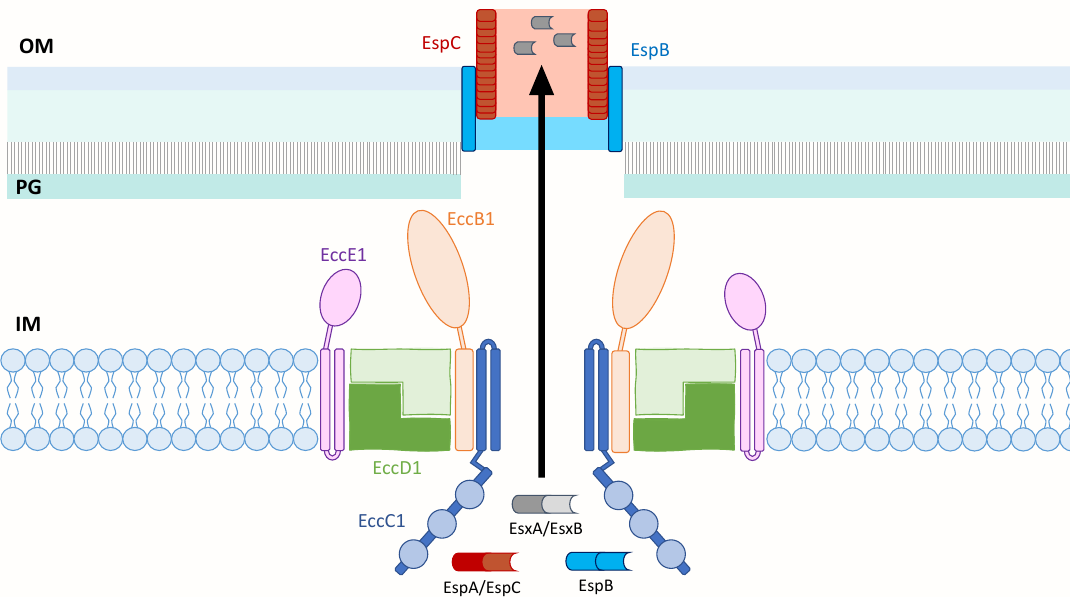
Figure 2. Model of the M. tb ESX-1 core membrane complex that is likely composed of EccB1, EccC1, EccD1 and EccE1 in a 1:1:2:1 ratio. EccC1 is shown with a flexible domain adjacent to the IM, followed by three ATPase domains represented by blue circles. When ESX-1 substrates contact EccC1, ATP hydrolysis occurs and is likely followed by conformational changes in the secretion apparatus to enable protein transport across the IM. The secreted EspB and EspC proteins may form an extended channel through the OM and into the extracellular milieu to transport EsxA across the OM. Inner membrane (IM); peptidoglycan (PG); outer membrane (OM).